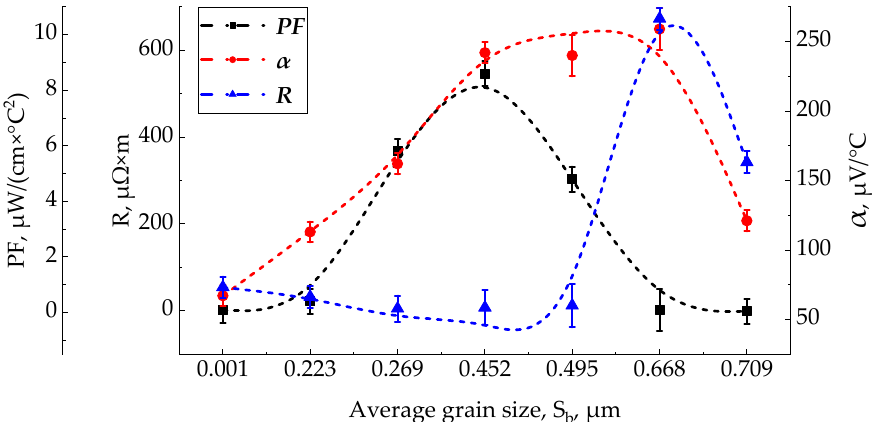
Figure 6. Plot of basic properties, α , R, PF, versus average grain size, S b .